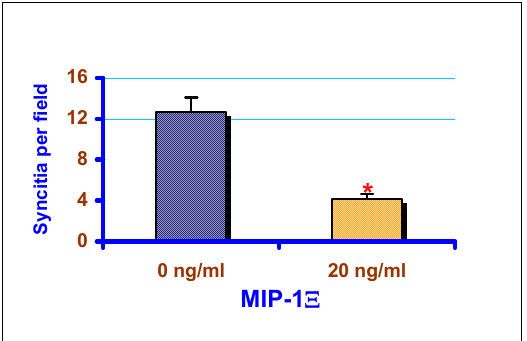
Figure 6. Exogenous MIP-1 α inhibits CAEV replication in GSMC in vitro . rHu 20 ng/ml MIP-1 α was added 3 h prior to infection with 1 X 10 6 TCID /ml CAEV, and at 24 h and 48 h post-infection. rHu 50 MIP-1 α (20 ng/ml) reduced syncytia formation by 75%. After 72 h, supernatants were harvested for the determination of RT activity. *indicates significant difference from control (P ≤ 0.01).